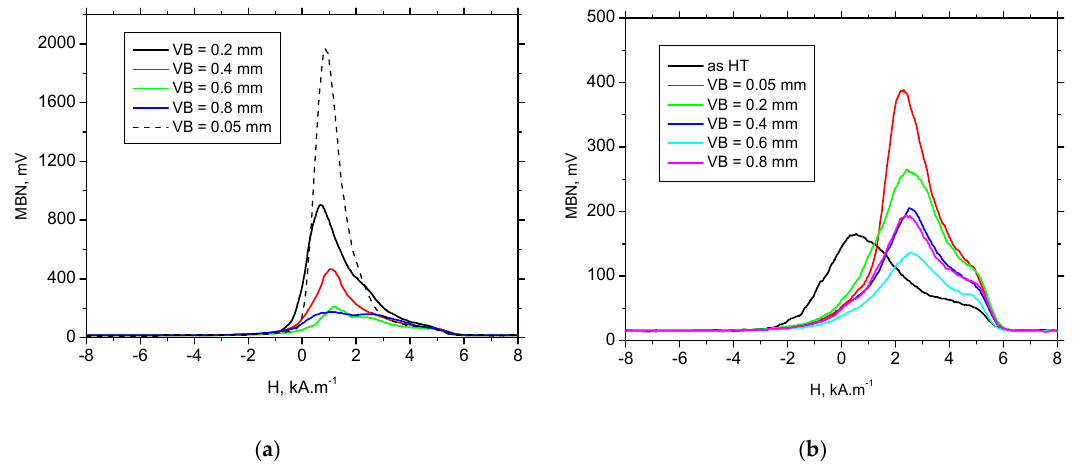
Figure 14. MBN envelopes: ( a ) for tangential direction, and ( b ) for axial direction.